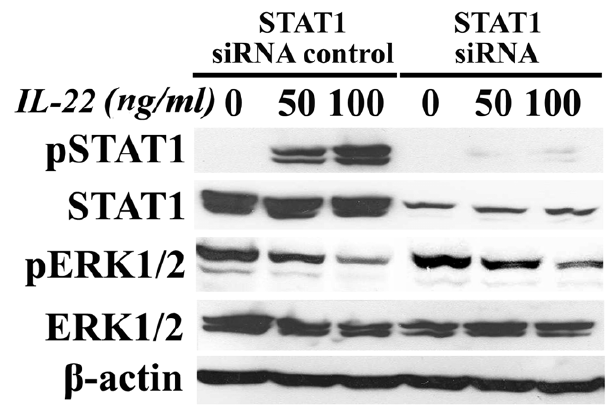
Figure 6. STAT1 and ERK1/2 pathways in A498 cells transfected with STAT1 siRNA by western blot assay. The expression of p-STAT1 decreased by 87.2% 6 3.6% in STAT1 siRNA transfected cells at the 30 th minute after IL-22 treatment and maintained in a lower level compared with that of negative control siRNA (P , 0.05).